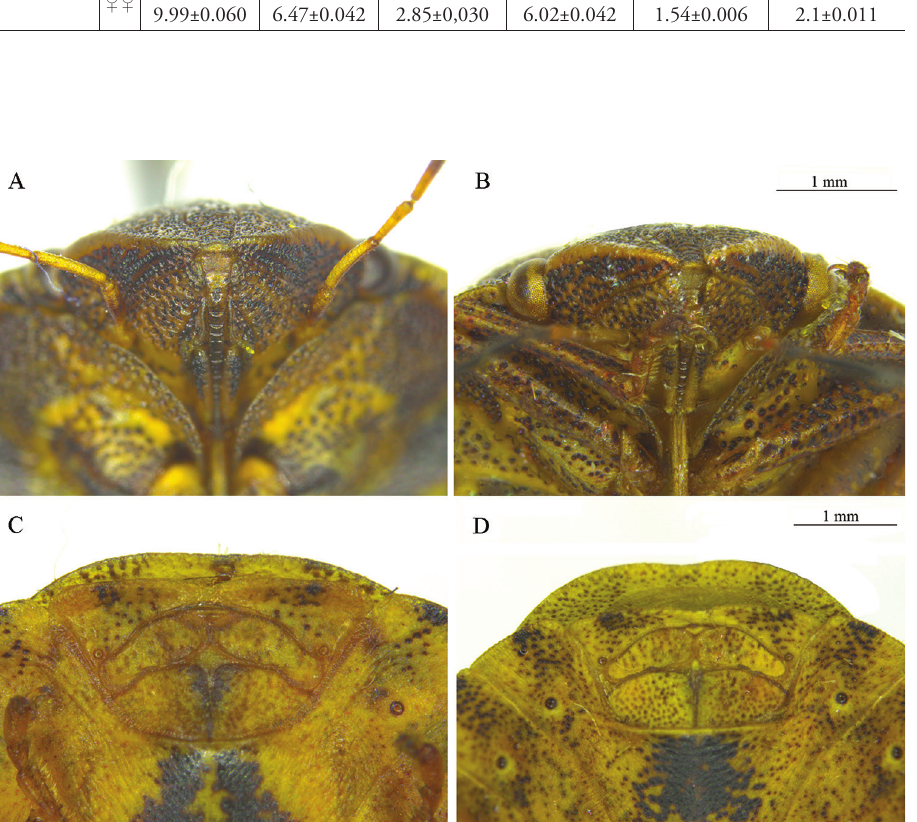
Figure 6. Head, anterior view ( A, B ) and female median genital plates ( C, D ) of E. maura L. ( A, C ) and E. testudinaria (Geoffroy) ( B, D )